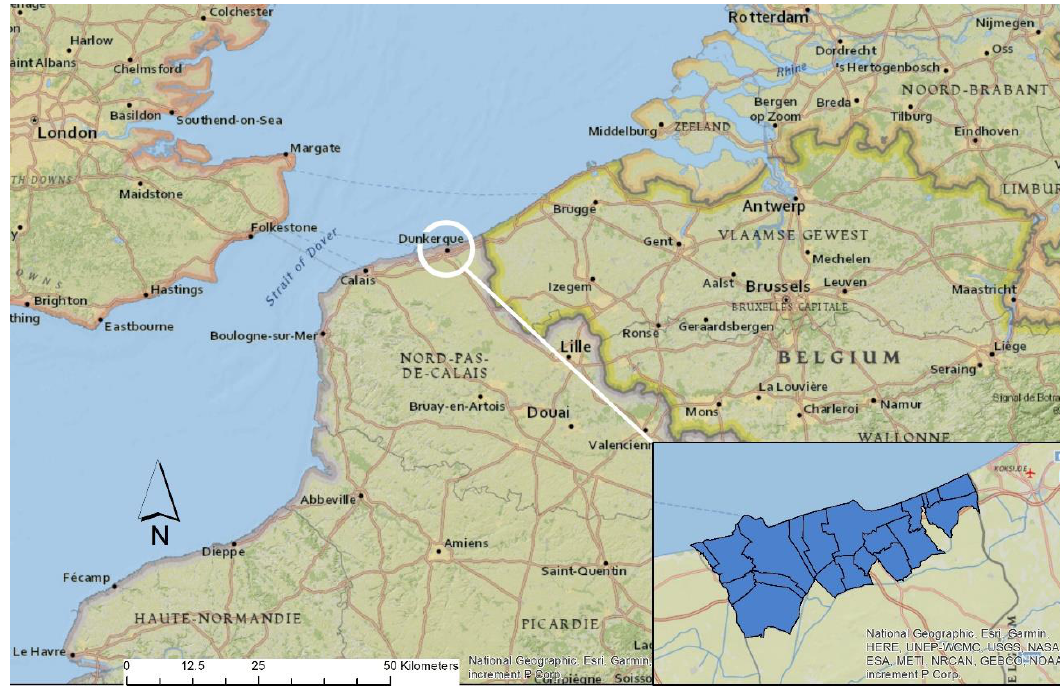
Figure 1. Map of the North Sea coast of France and Belgium with the location of the metropolitan area of Dunkirk and its neighboring environment. Map made using ArcGIS with the Basemap of the National Geographic and an online database on Dunkirk.